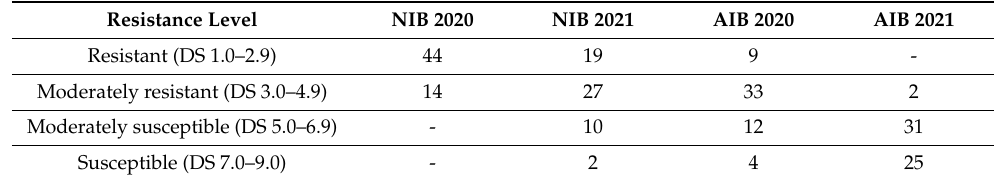
Table 1. The distribution of 58 rye accessions from the genetic resources of the Vavilov All-Russian Institute of Plant Genetic Resources, by resistance categories, during the growing seasons, 2019–2020 and 2020–2021, under a natural infection background (NIB) and an artificially-enriched infection background (AIB). DS—disease score.